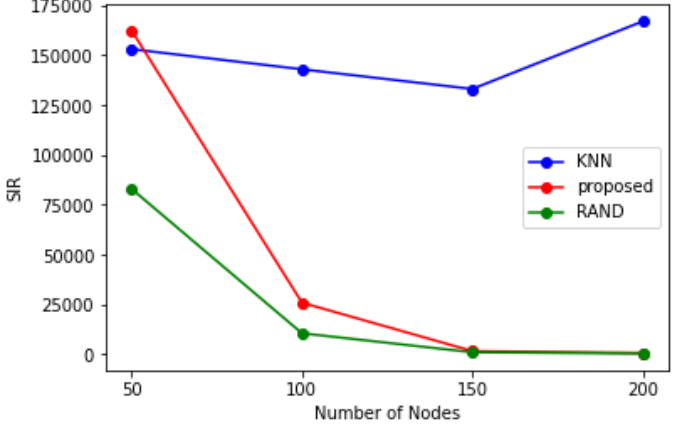
Figure 2. Comparison of the average SIR obtained by each